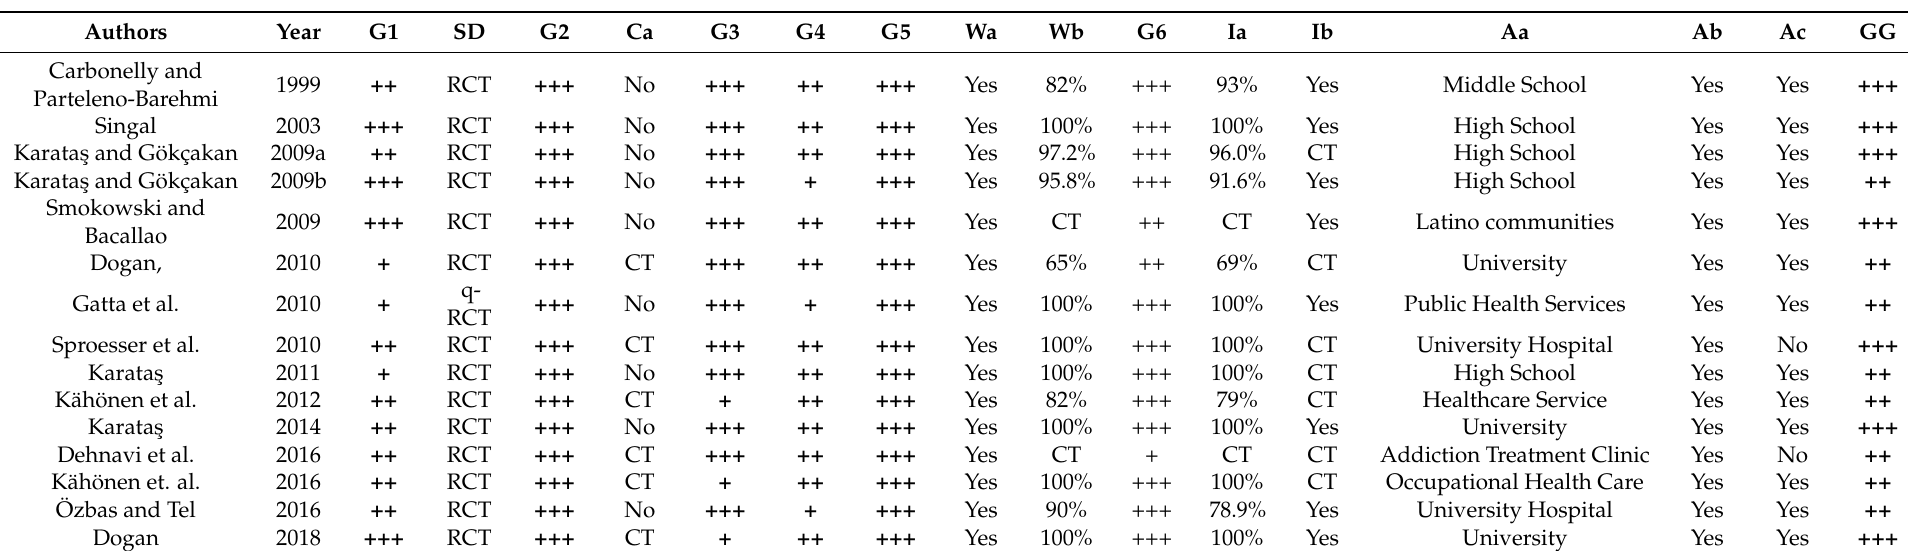
Table 2. Quality assessment tool for quantitative studies (Wess et al.,